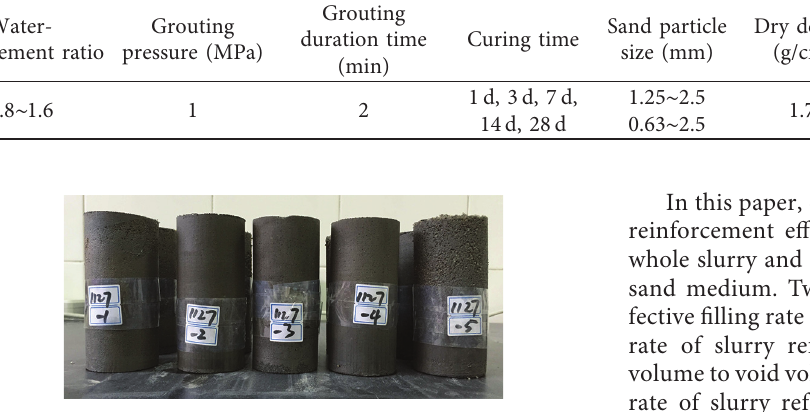
Table 3: Relevant test parameters.